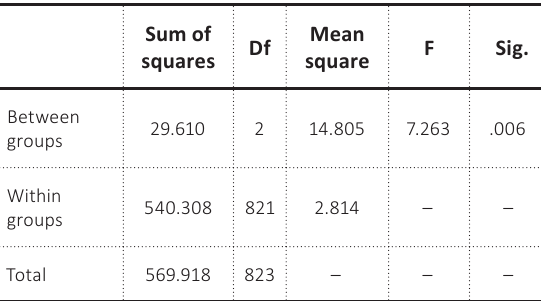
Table 1. ANOVA test for